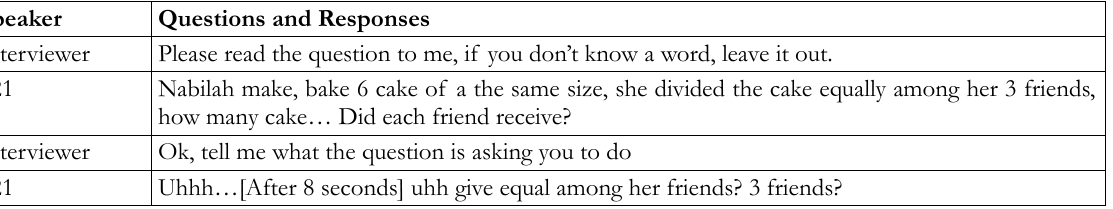
Table 3. Interview excerpts from student S21